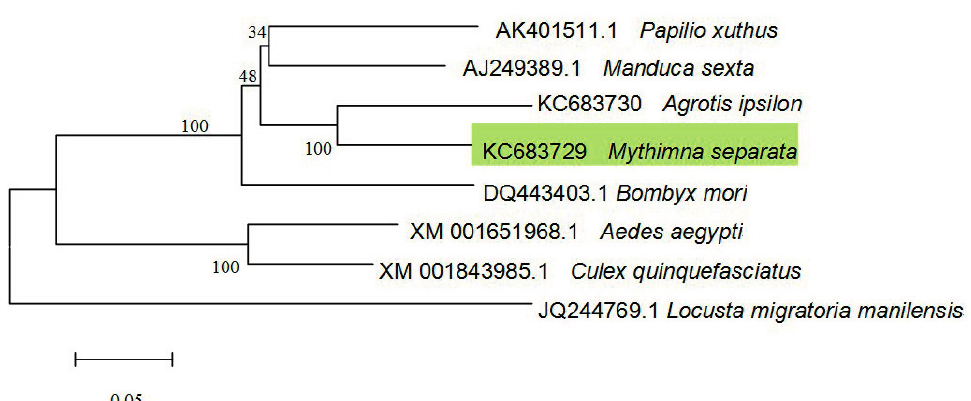
Figure 2. Phylogenetic relationship of V-ATPase subunit H. This un-rooted phylogenetic tree was constructed by the neighbor-joining method. Nodes indicate bootstrap calculated with 1000 replications